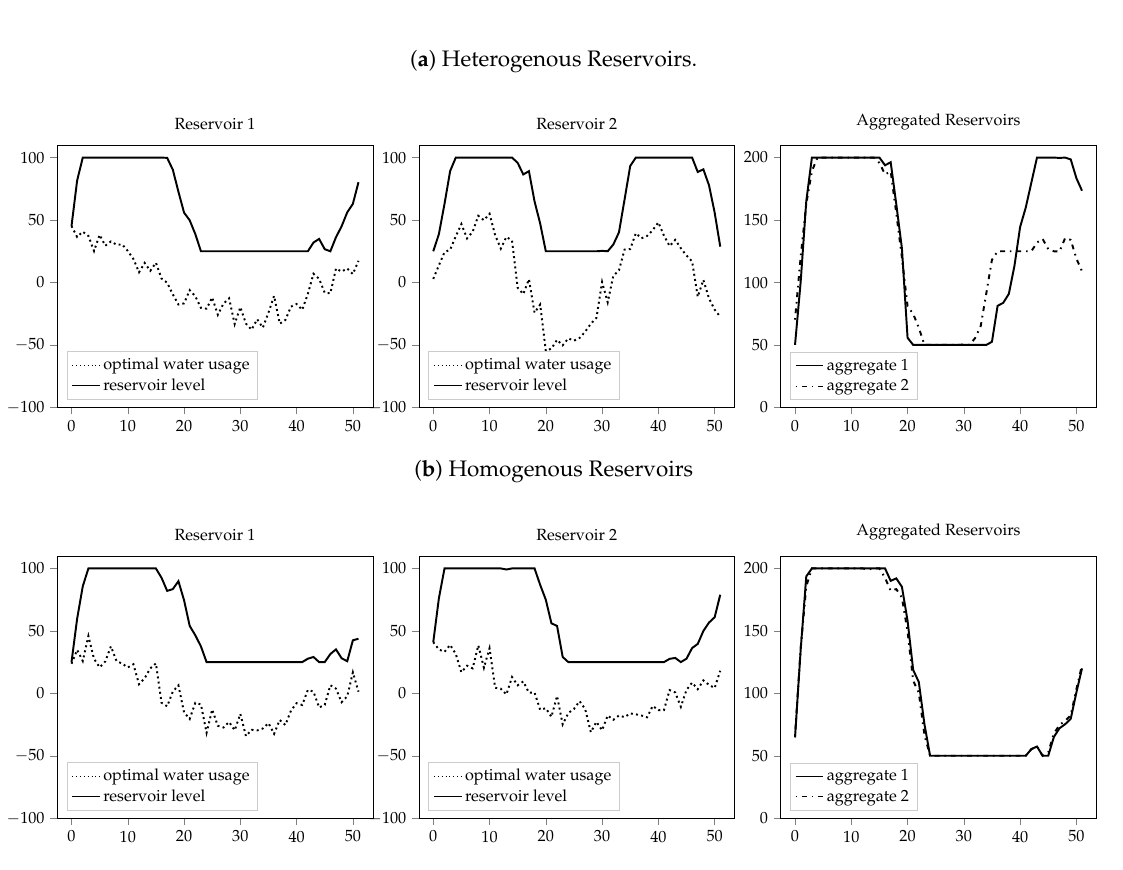
Figure 1. Aggregates for different Reservoir